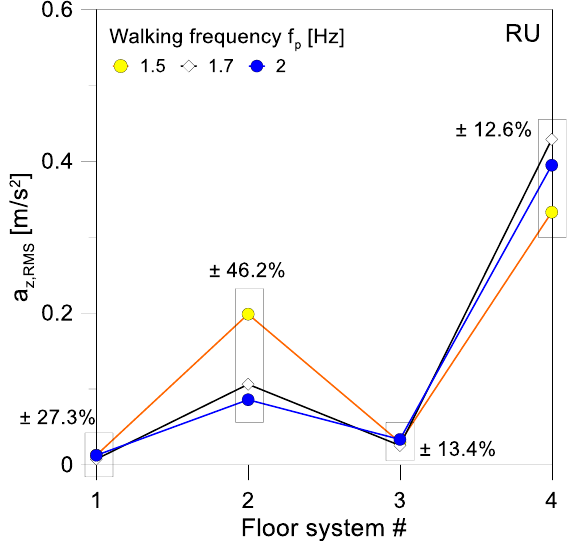
Figure 7. Numerical results for F#1 to F#4 floor systems, based on equivalent-force calculations (RU model), in terms of RMS acceleration, as a function of walking frequency f p (ABAQUS).